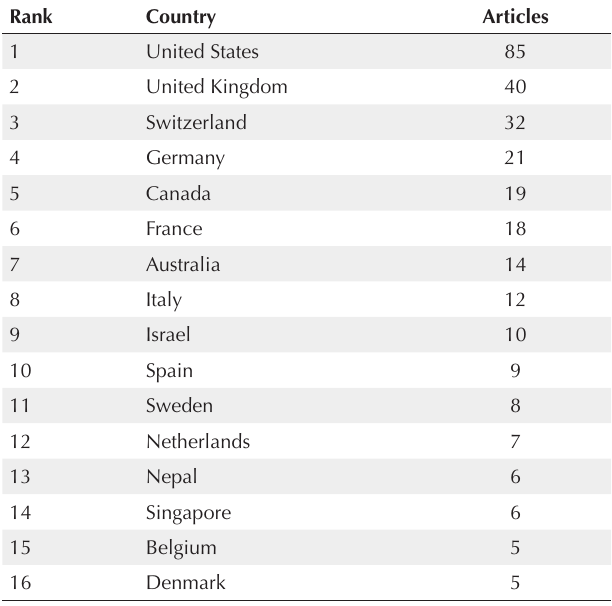
Table 5. Countries of Origin of the Most Cited Articles